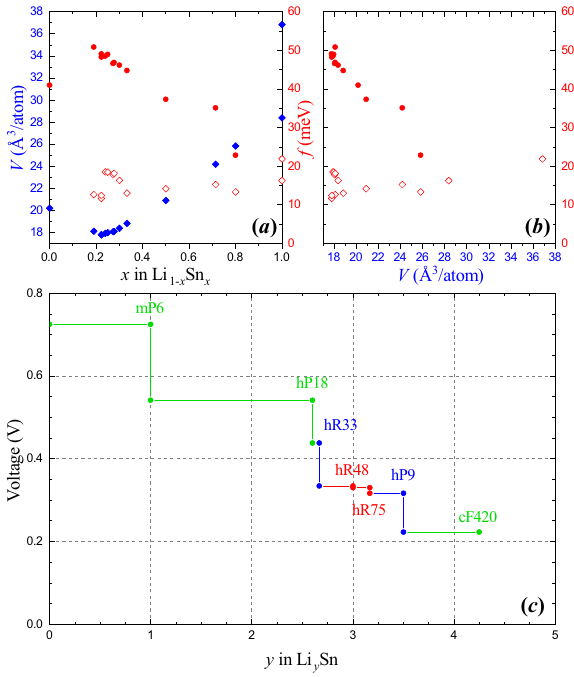
Fig. 9 DFT analysis of select Li-Sn phase properties. a Atomic volume (blue diamonds), highest Li phonon frequencies (solid red circles), and highest Sn phonon frequencies (empty red diamonds) evaluated at ambient pressure as a function of the alloy composi- tion. b The same highest Li and Sn phonon frequencies as a function of the atomic volume. c Voltage for stable Li y Sn alloys re fi ned through addition of two hR48-Li 3 Sn and hR75-Li 19 Sn 6 ground states predicted in this